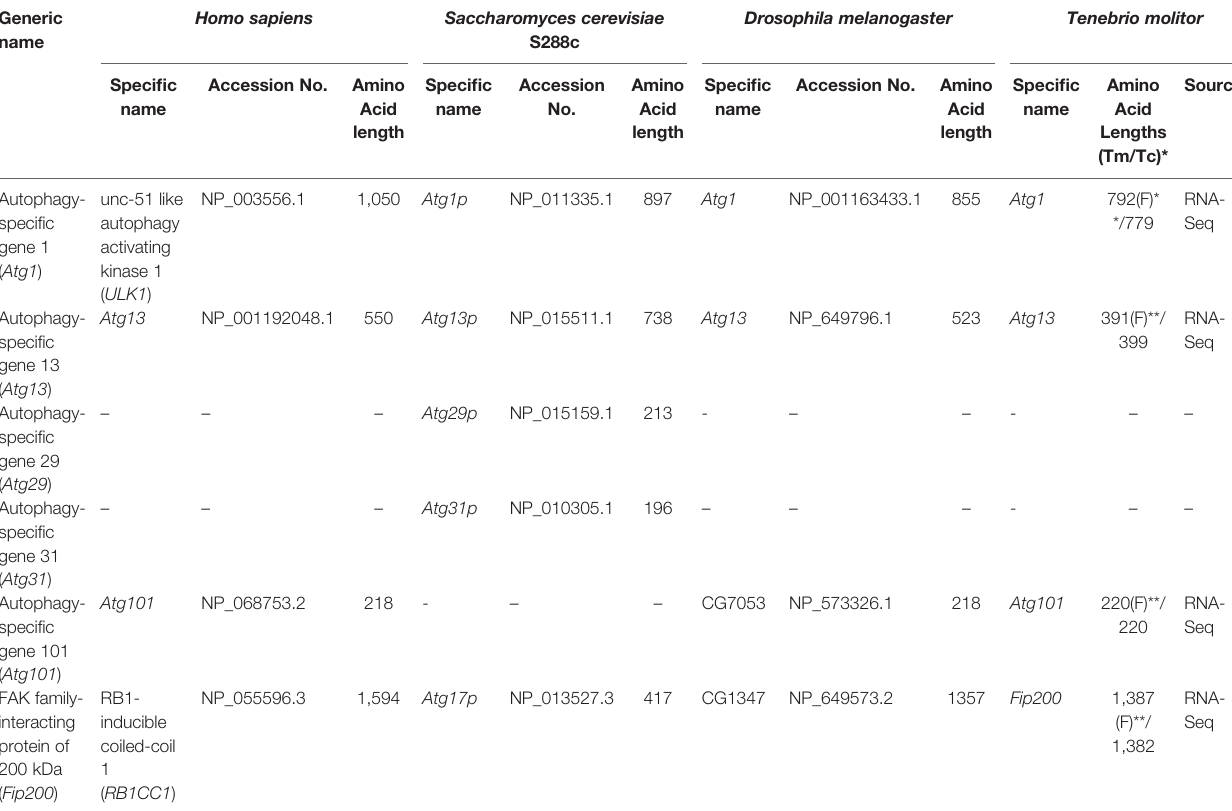
TABLE 2 | Autophagy-related genes involved in autophagy initiation in T. molitor